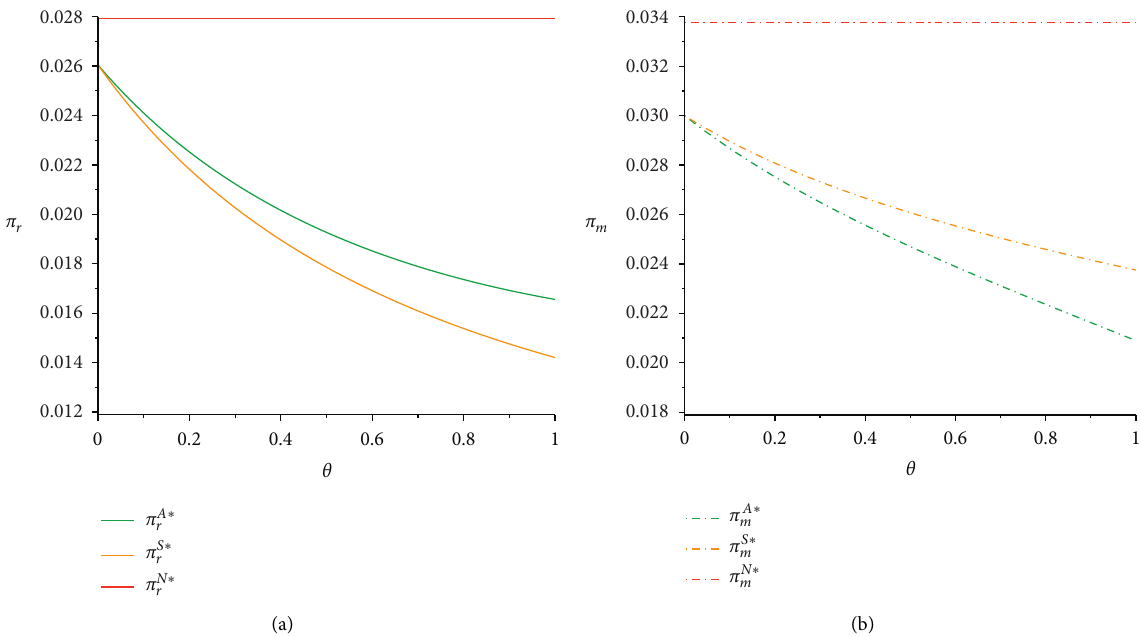
Figure 2: Comparison results of profits versus parameter θ when a � 0 . 5, b � 0 . 2, and c � 0 . 8. (a) Retailer’s equilibrium profits under three models. (b) Manufacture’s equilibrium profits under three